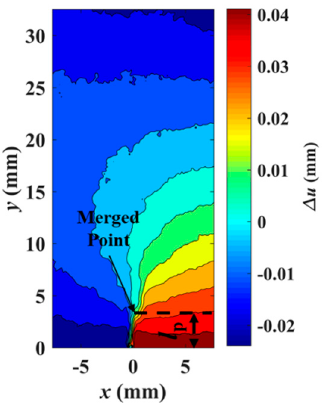
Figure 6. Incremental horizontal displacement contours of oil-saturated sample.